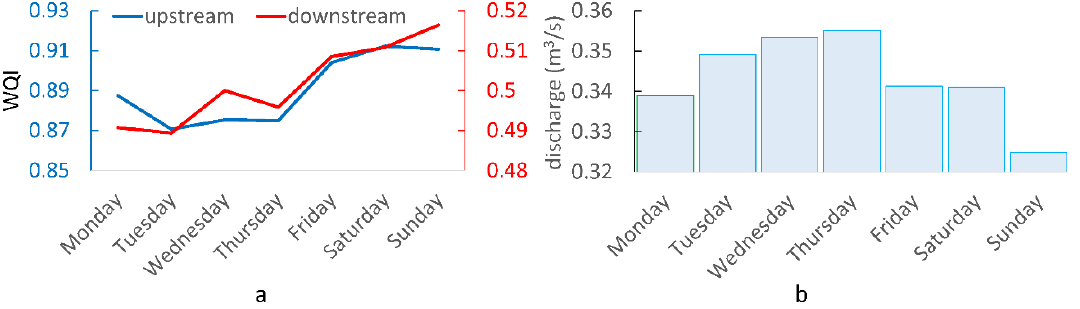
Figure 8. Weekly regime of some studied waters in 2019 (averaged daily data): ( a ) Suceava River WQI; ( b ) treated wastewater discharge from WWTP.